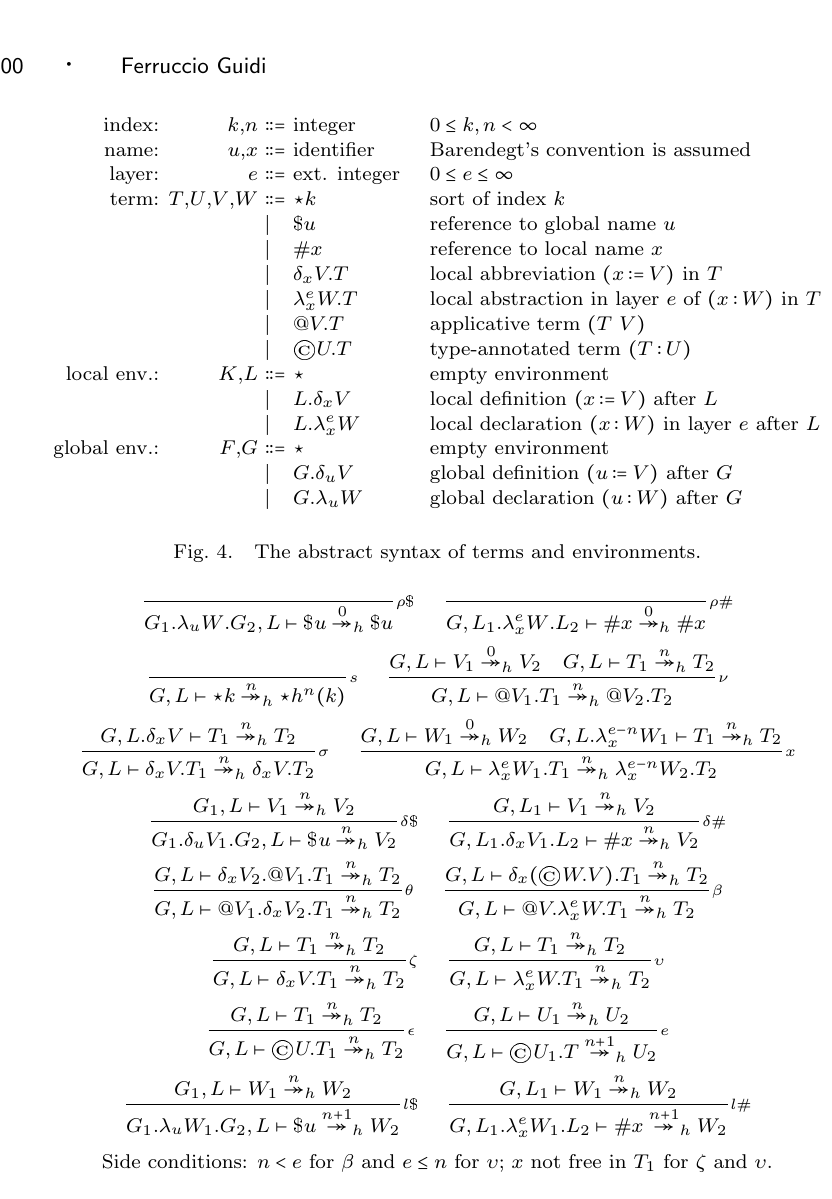
Fig. 5. The proposed rt -transition